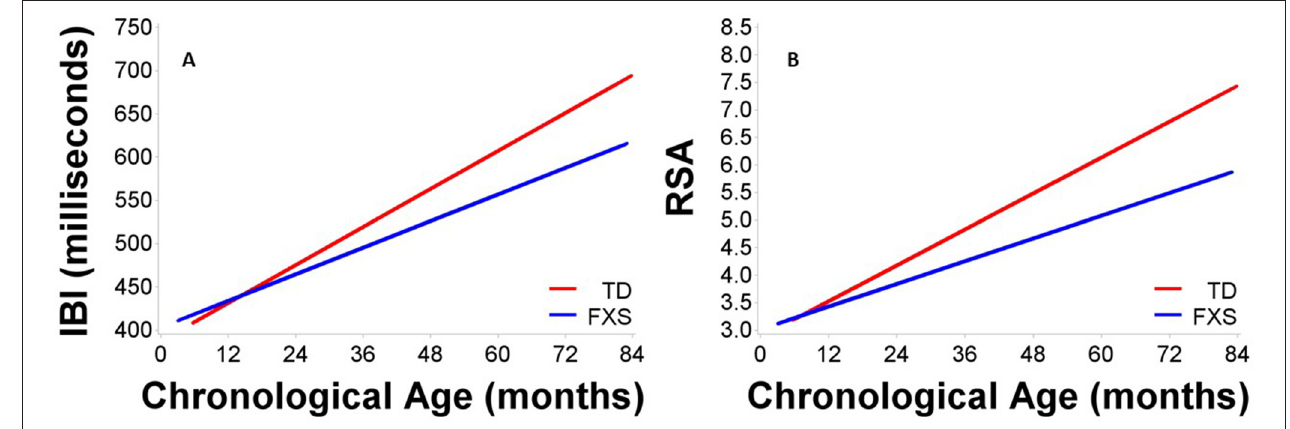
FIGURE 2 | Maturation in (A) IBI and (B) RSA across age in males with FXS and TD males. Males with FXS are indicated in blue; TD males are indicated in red.